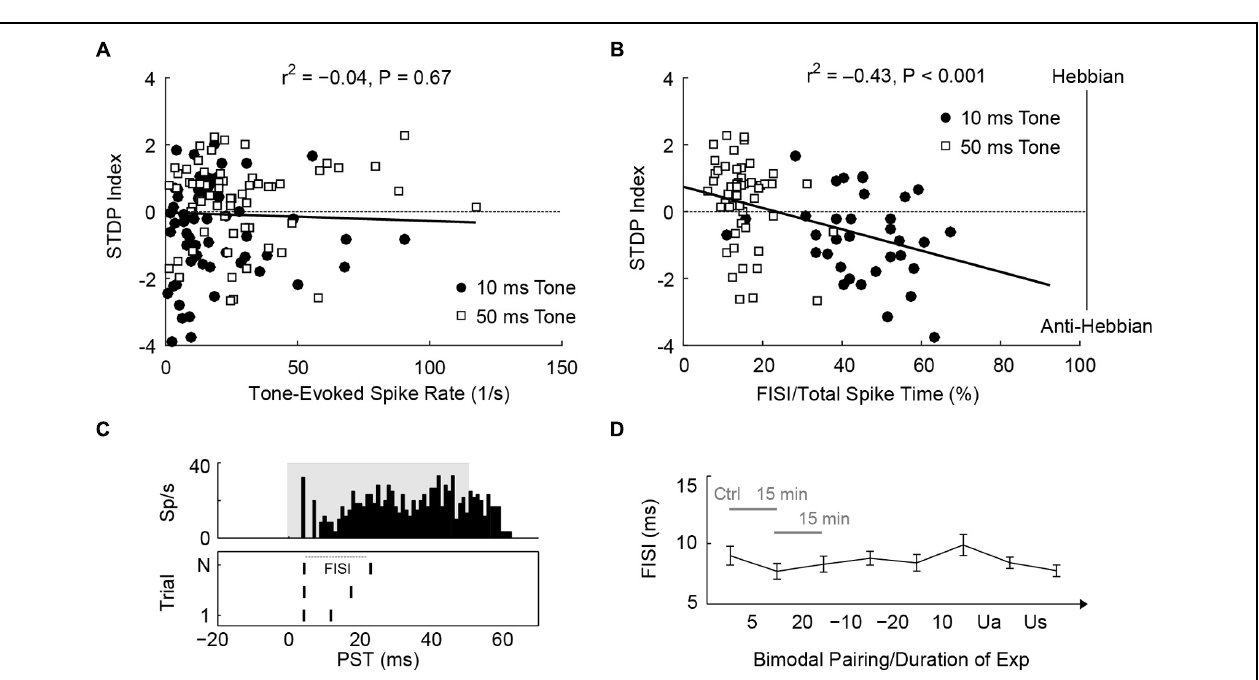
spike activity correlates with STDP index. (D) FISIs were tracked across the duration of an STDP experiment ( n = 30 units, paired 50 ms tones and face/Tg stimulation). The first data point was assessed before STDP induction, subsequent data points were assessed 15 min after each bimodal interval. The bimodal pairing protocol used is indicated between each data point. Ua, unimodal auditory; Us, unimodal